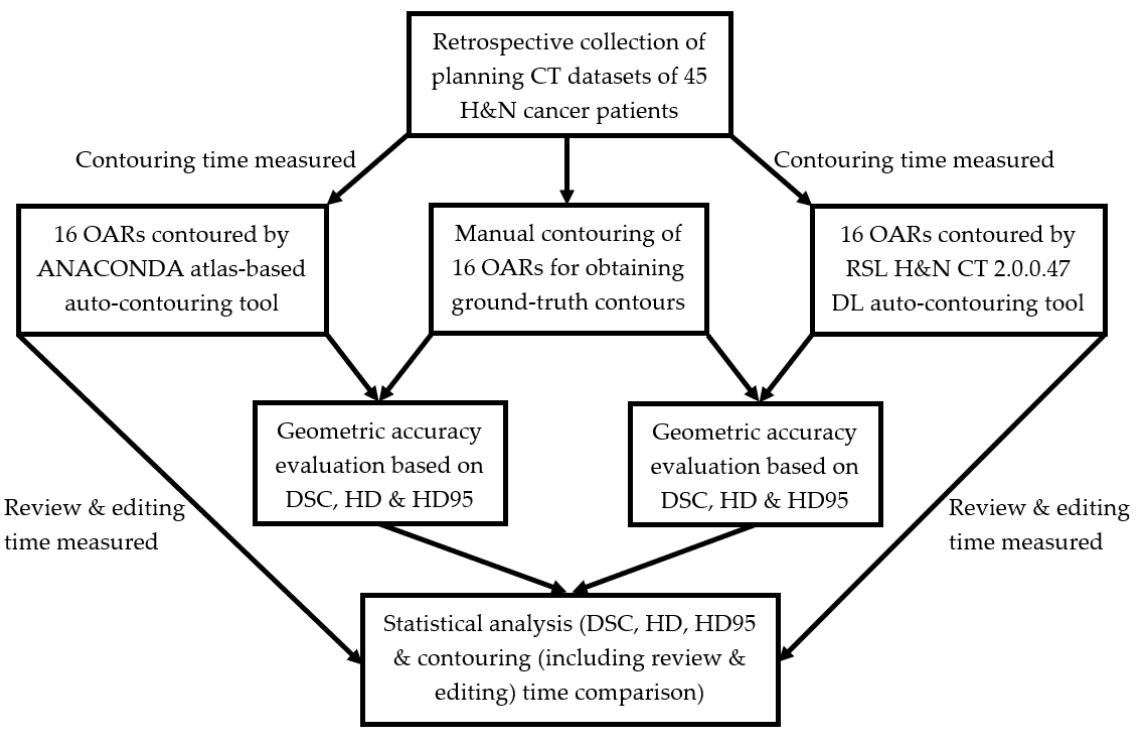
Figure 1. Study design overview. ANACONDA-ANAtomically Constrained Deformation Algorithm; CT-computed tomography; DL-deep learning; DSC-Dice similarity coefficient; H&N-head and neck; HD ‐ Hausdorff distance; HD95 ‐ HD 95th ‐ percentile; OARs ‐ organs at risk.